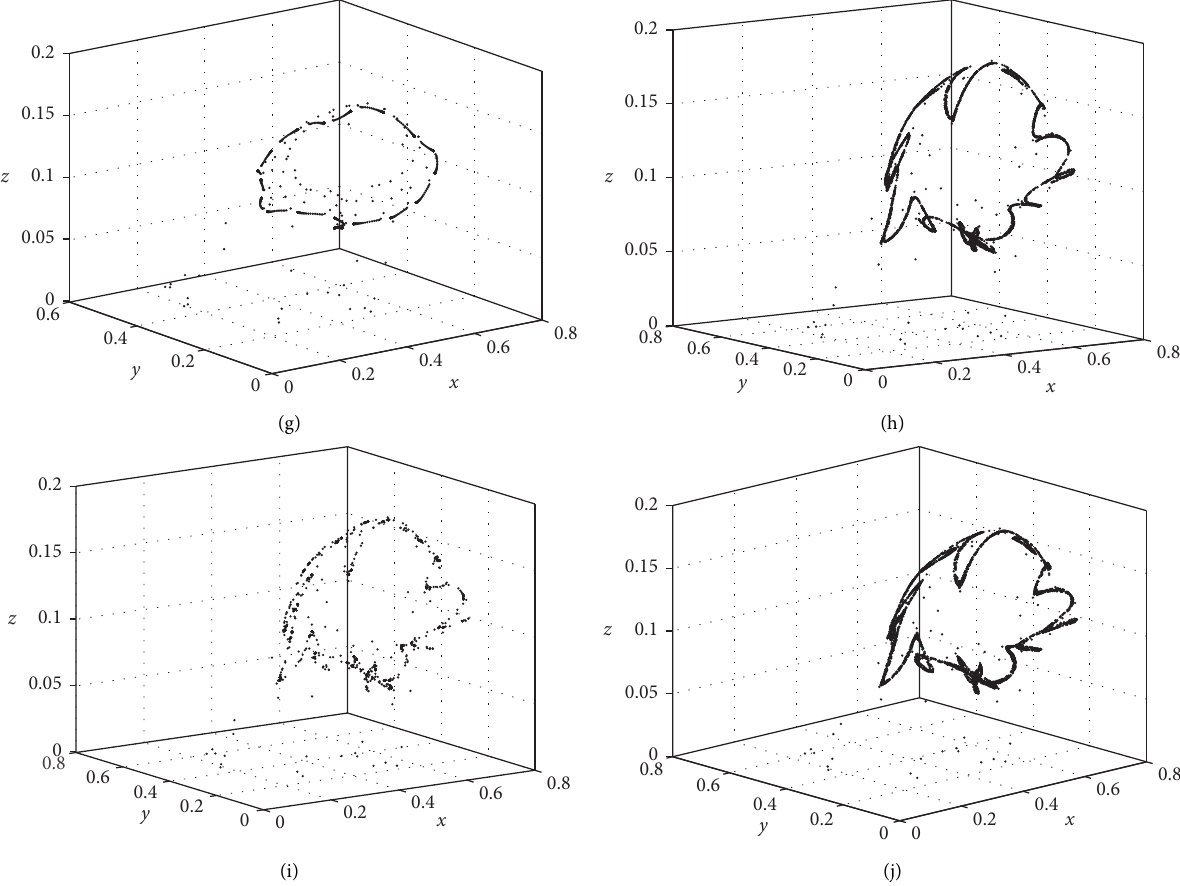
Figure 3: The phase diagrams of equation (5) ((a, b) 2.94 < a < 2.99, (c) a � 3.01, (d, e) 3.01 < a < 3.6, (f) a � 3.87, (g) a � 3.904, and (h–j) 3.904 < a < 3.998).